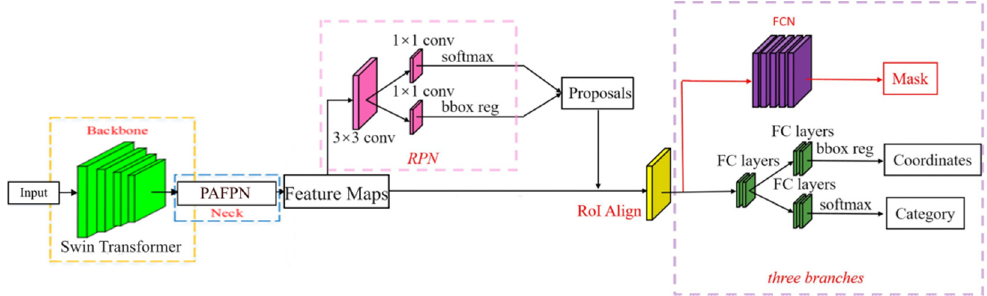
Figure 8. The structure of our improved forest fire detection model, STPM.